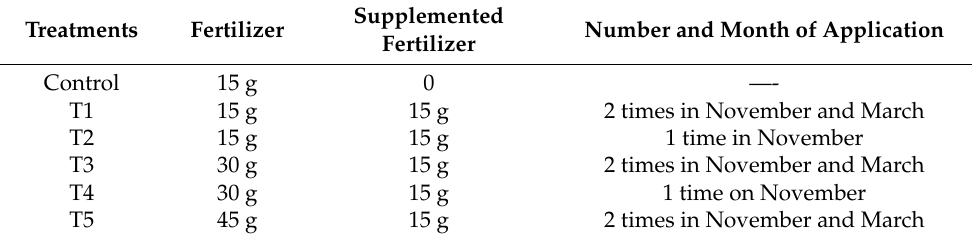
Table 1. Treatments, fertilizer amounts, and supplemented fertilizer amounts